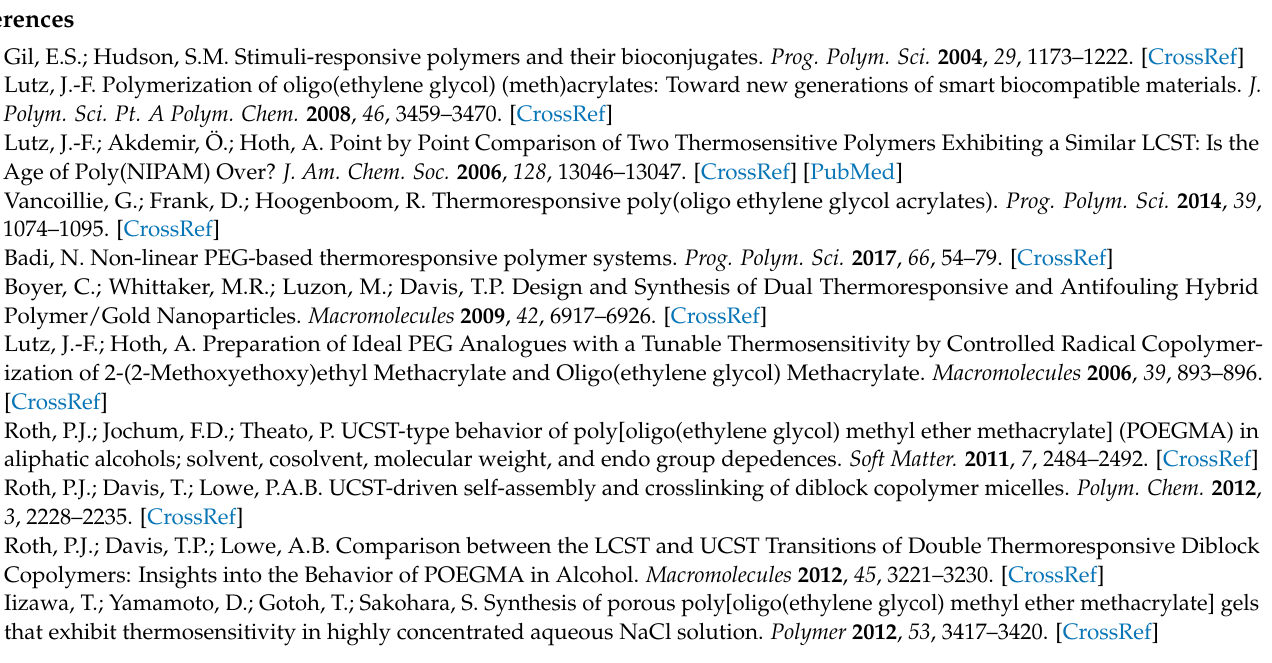
Figure S2: (a) The effect of temperature on contact angle of PTEGA gel, (b) the effect of temperature on transition behavior of PTEGA gel in pure water; Figure S3: Measurement of contact angle of a